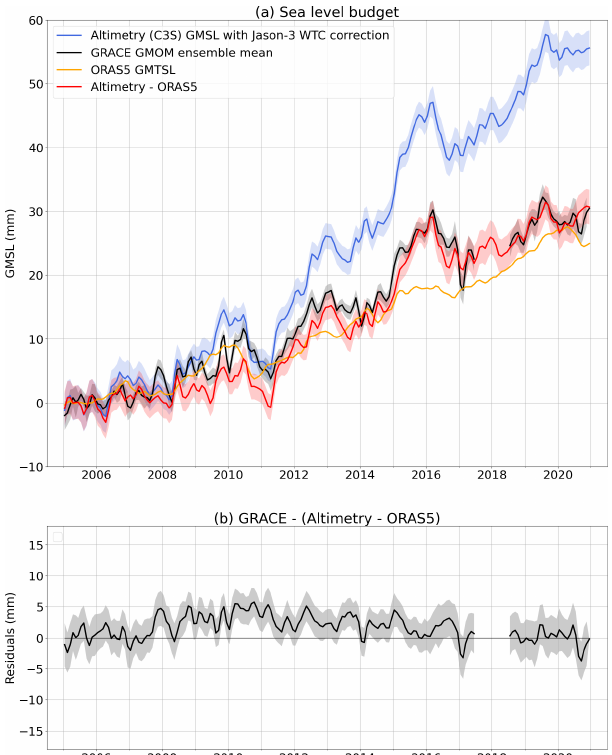
Figure 9. Sea level budget. (a) Budget with GRACE/GRACE-FO- based global mean ocean mass (GMOM) variations compared to altimetry-based GMSL (corrected for the Jason-3 radiometer WTC drift) and CERES-based GMTSL (using the trend from ORAS5). (b) Budget residuals. Linear trends of all components over different periods of time are provided in Table